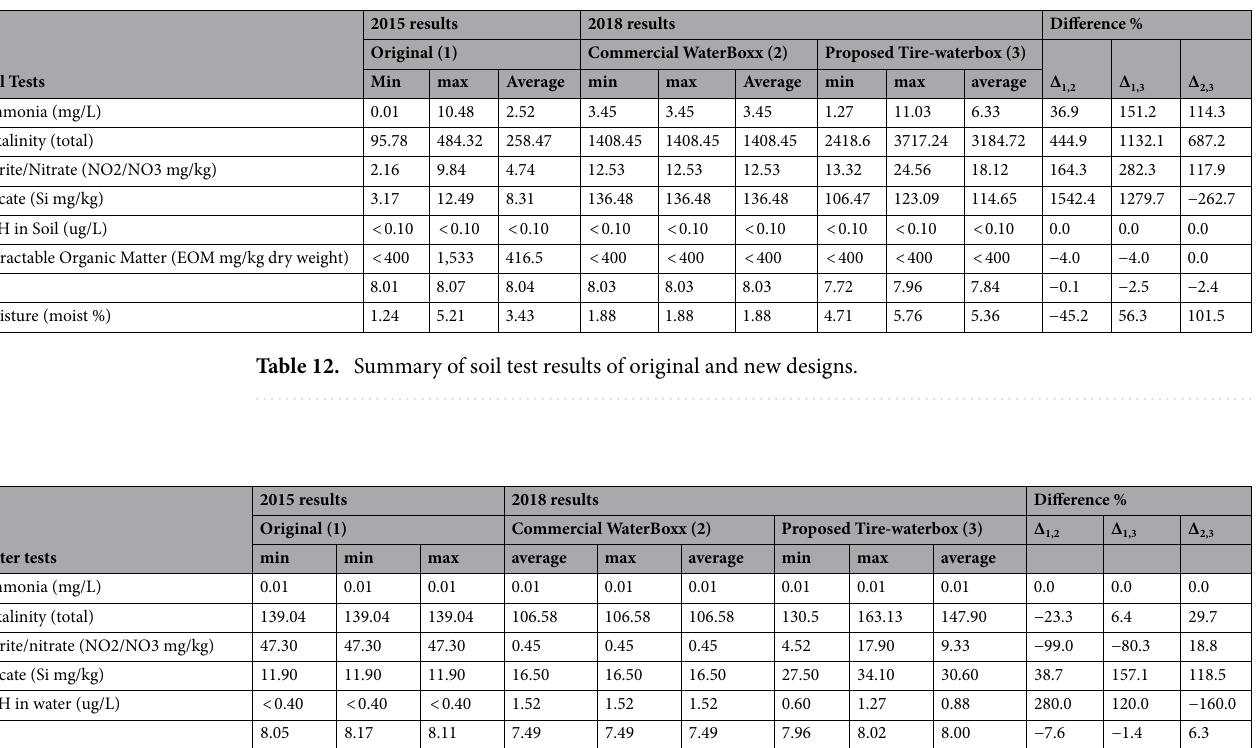
Table 13. Summary of water test results of original and new